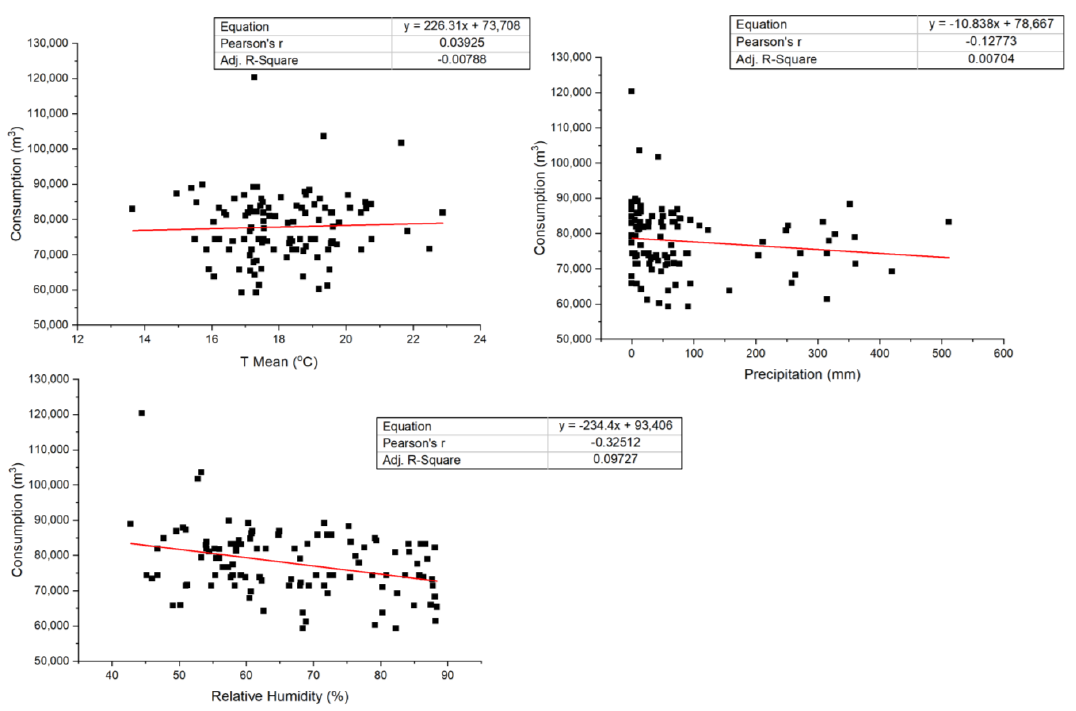
Figure 10. Monthly water consumption trendline for the climate variable of Debre Birhan (2012 – 2020).